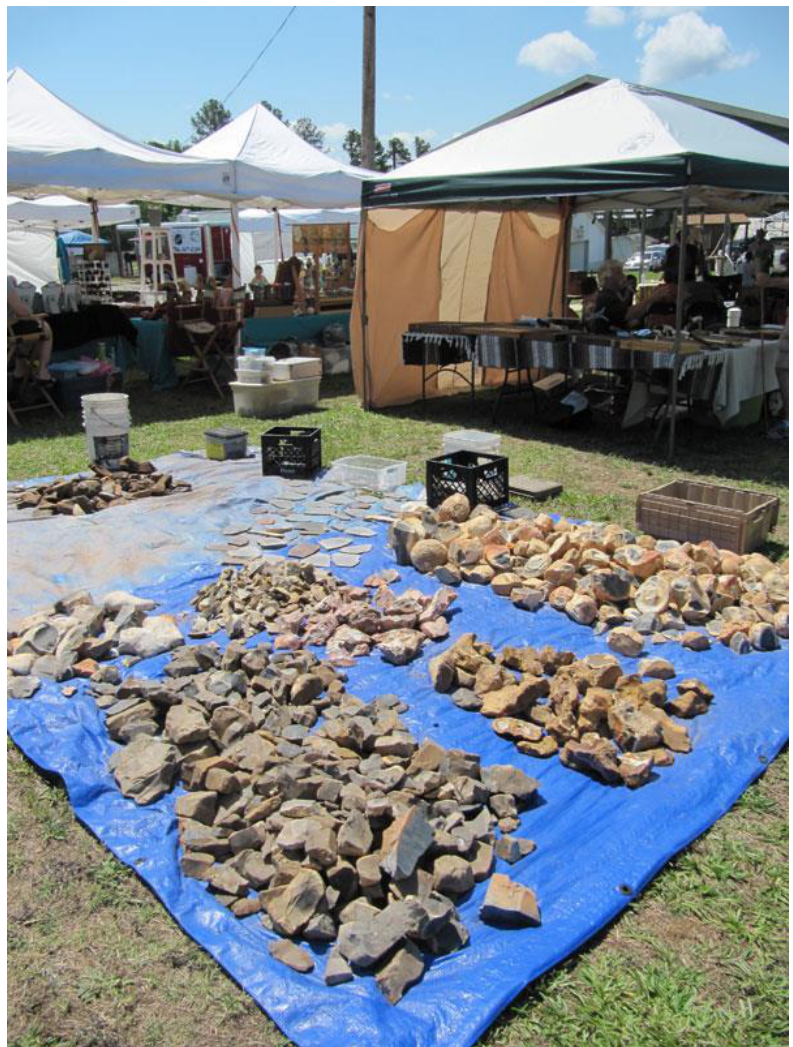
Figure 2. A selection of knapping material available for sale at the event. (Photo by Michael